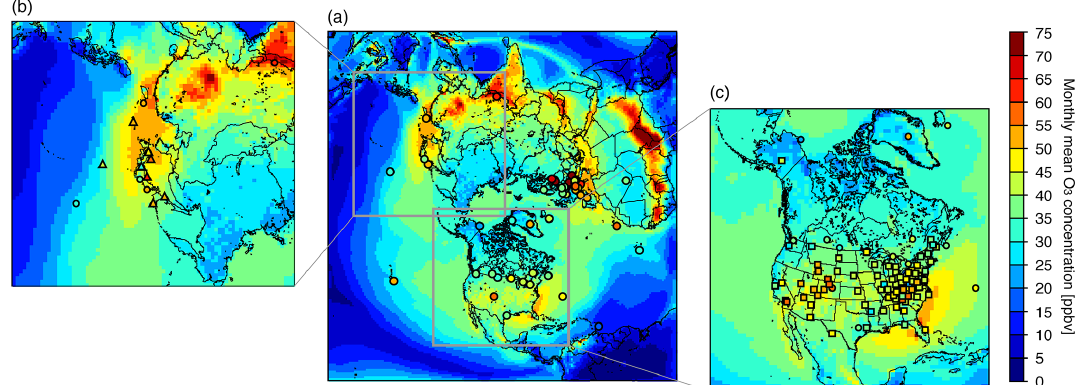
Figure 3. Monthly mean H-CMAQ O 3 mixing ratios overlaid with (b) WDCGG surface observations over the Northern Hemisphere, and zoom-in panels over (a) Asia overlaid with EANET surface observations and (c) US overlaid with CASTNET surface